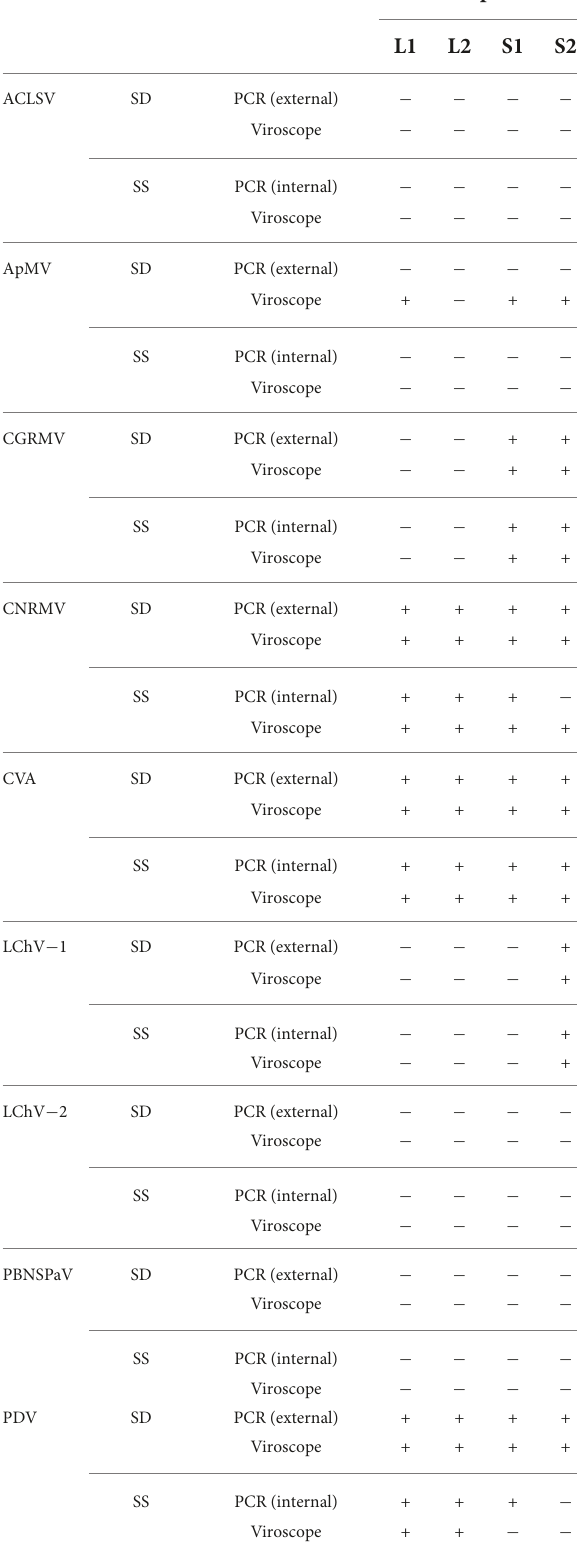
TABLE 3 Pipeline validation by RT-PCR. Virus